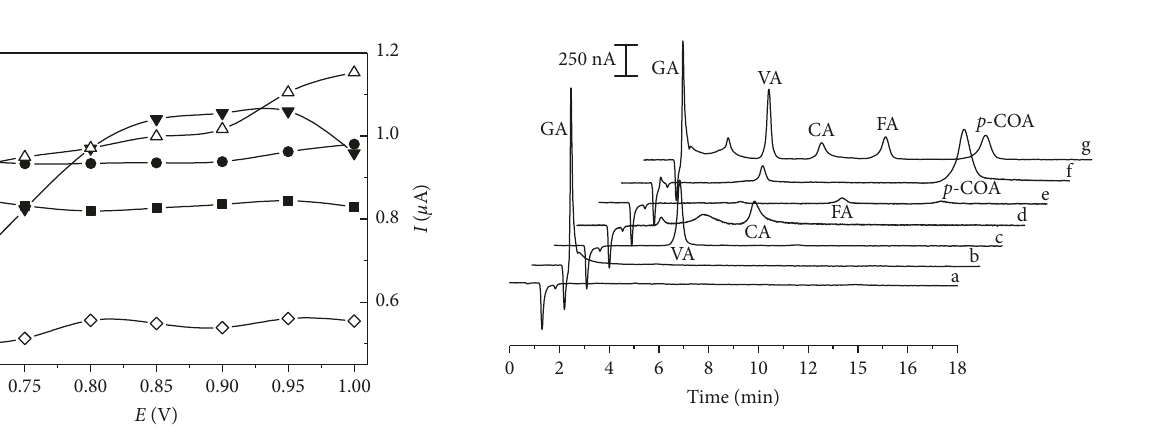
Figure 6: Chromatograms acquired for blank solution (a), gallic (b), vanillic (c), caffeic (d), ferulic (e), and p-coumaric acids (f) and for the mixture of standard solutions of the analytes (g). L ·